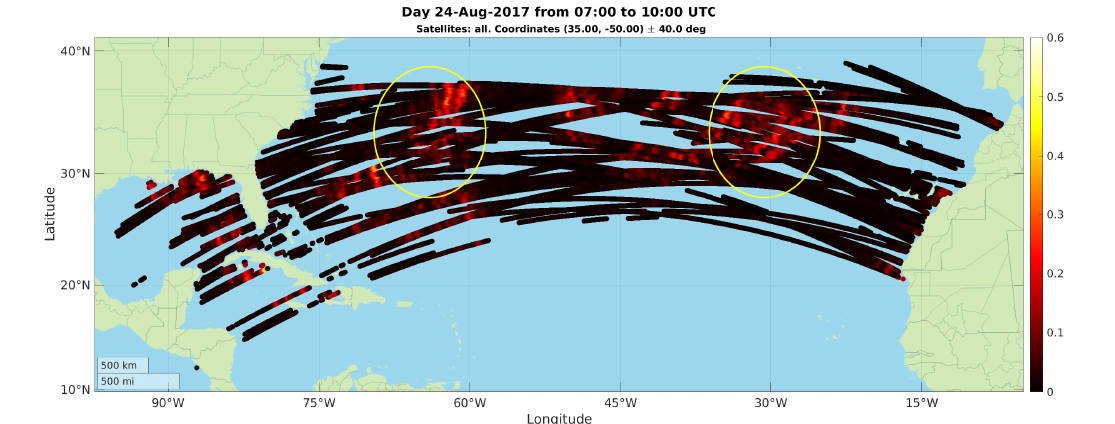
Figure 9. S 4 values over the Northern Atlantic for 24 August 2017, showing two regions of moderate scintillation.